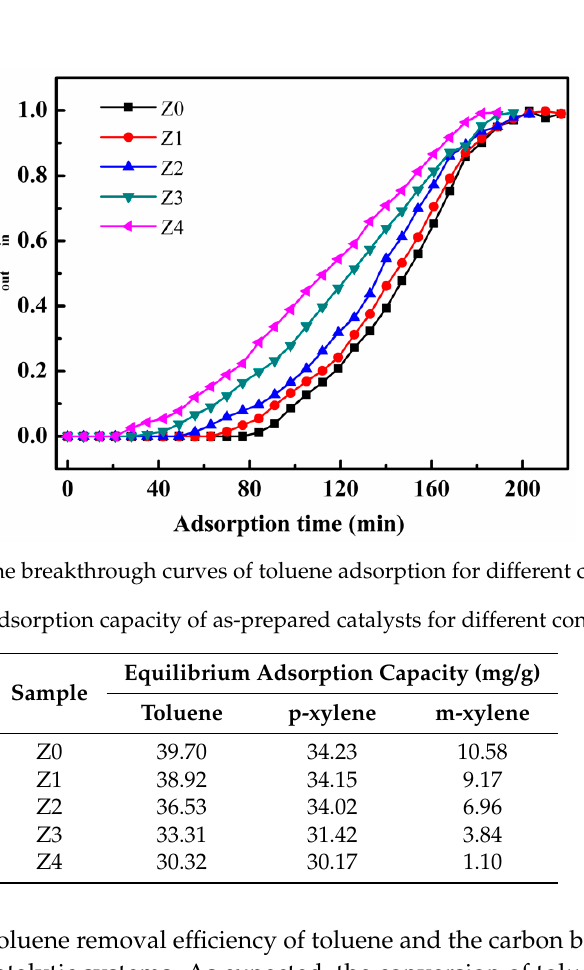
Table 3. The adsorption capacity of as-prepared catalysts for different contaminants. Equilibrium adsorption capacity (mg/g) Sample